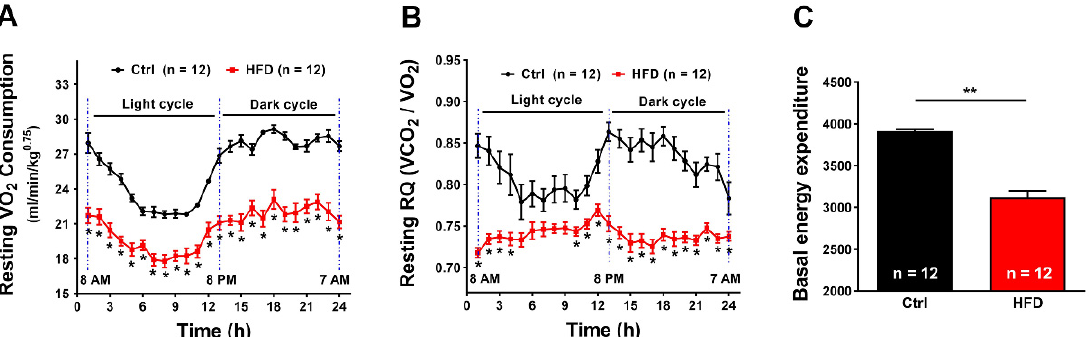
Figure 2. VO 2 consumption, respiratory quotient (RQ), and basal energy expenditure during 24 h. ( A ) Oxygen consumption expressed as mL/min/kg 0.75 . ( B ) Respiratory quotient expressed as the ratio VCO 2 /VO 2 . ( C ) Area under the curve of 24 h-basal energy expenditure. Data are shown as mean ± SEM (* p < 0.05 and ** p < 0.01), as evaluated by two-way ANOVA followed by Tukey’s post-hoc test (panels ( A , B )) and two-tailed unpaired Student’s t -test (panel ( C )). n = number of mice tested.